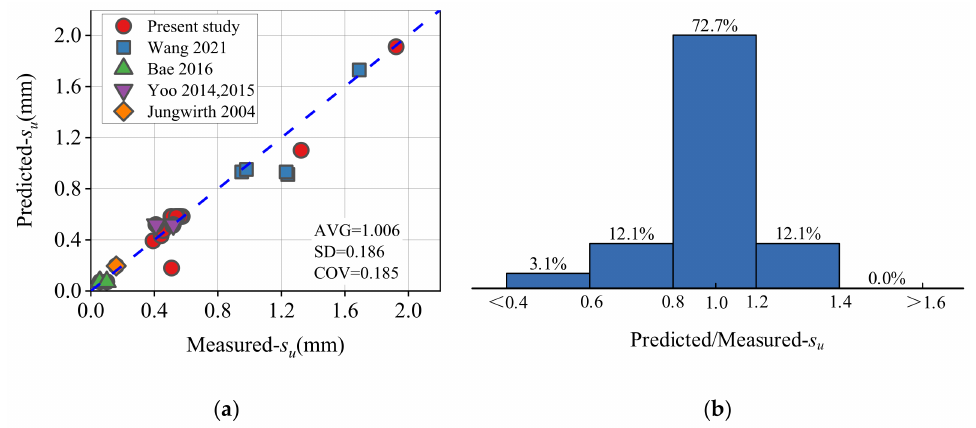
Figure 16. Comparative measured and predicted results: ( a ) the peak slip s u ; ( b ) histogram.